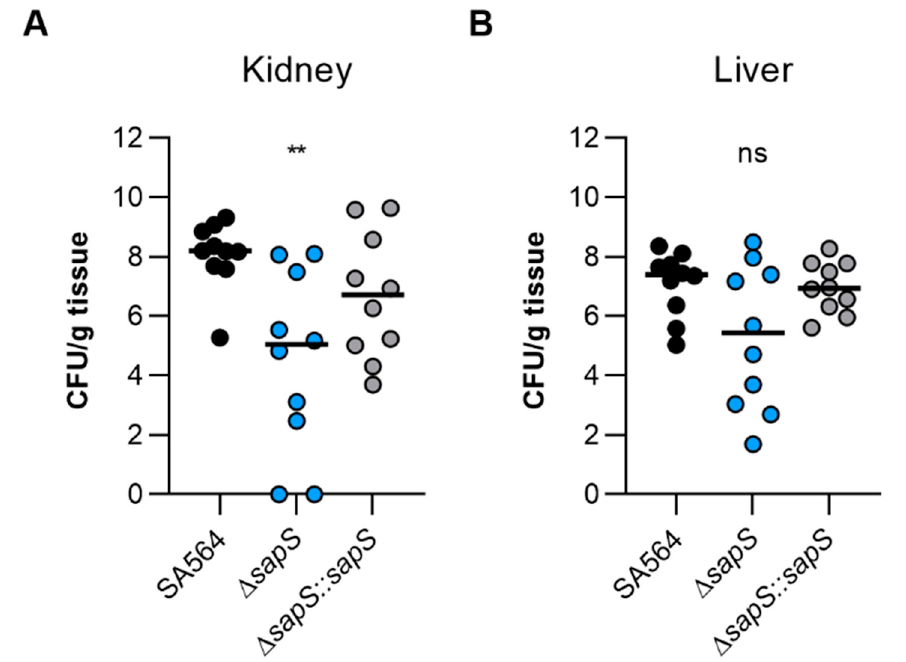
Figure 4. The virulence of S. aureus SA564 in a murine abscess model is enhanced by the presence of SapS. C57BL/6N mice were infected via retroorbital injection with 1 x 10 7 cells of S. aureus strain SA564 (black symbols), SA564 Δ sapS (blue symbols), and the cis -complemented derivative SA564 Δ sapS::sapS (grey symbols), respectively (n = 10 per group). Mice were euthanised and to evaluate the bacterial burdens in the kidney ( A ) and liver ( B ) organs, livers and kidneys were excised and homogenised in PBS 4 days after infection. Serial dilutions of the homogenates were then plated on sheep blood agar plates. One mouse is represented by each symbol. The median of all observations is indicated by the horizontal bars. ns, not significant; ** p < 0.01 (Kruskal–Wallis test followed by Dunn’s post hoc test). Only differences that are statistically significant between WT and mutants are displayed.